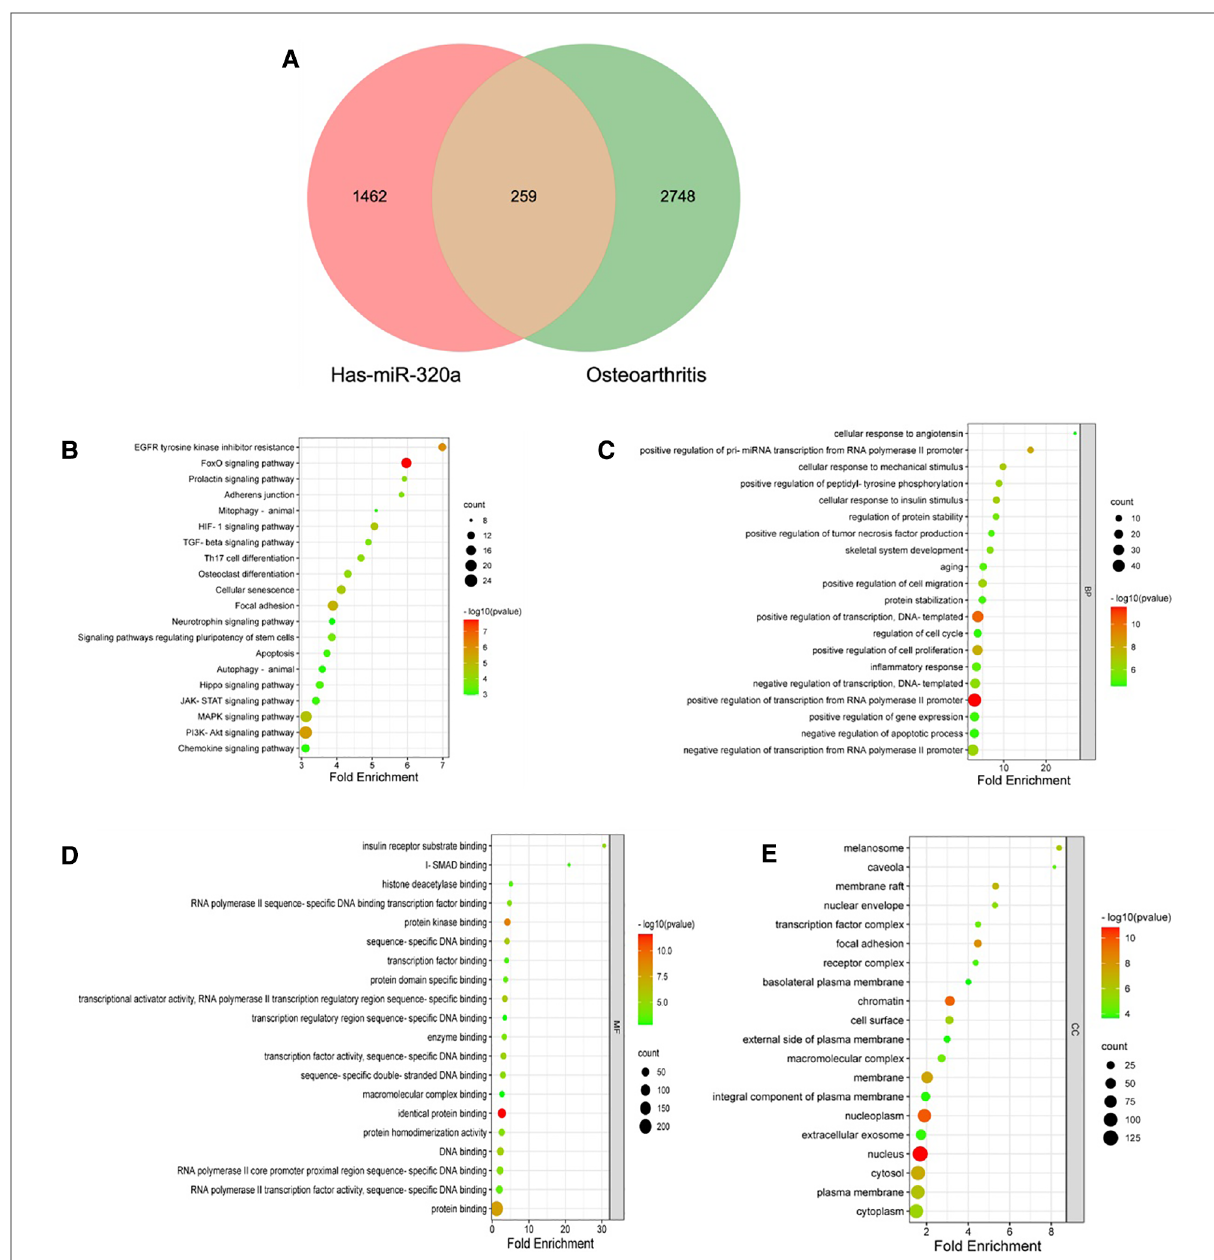
FIGURE 4 KEGG and GO pathway enrichment analysis of microRNA-320a-targeted genes which have the effect on OA. ( A ) PPI network was obtained from GeneMANIA database. The nodes represent genes and the edges represent connection between genes. Five key modules were identi fi ed by MCODE, which was used for network gene clustering. ( B ) Cluster 1 with 11.067 score. ( C ) Cluster 2 with 9.579 score. ( D ) Cluster 3 with 6.1 score. ( E ) Cluster 4 with 3.778 score. ( F ) Cluster 5 with 2.5 score. ( G ) Pathway enrichment analysis of cluster 1. The MAPK signaling pathway was signi fi cantly enriched. ( H ) Pathway enrichment analysis of cluster 2. The MAPK signaling pathway was signi fi cantly